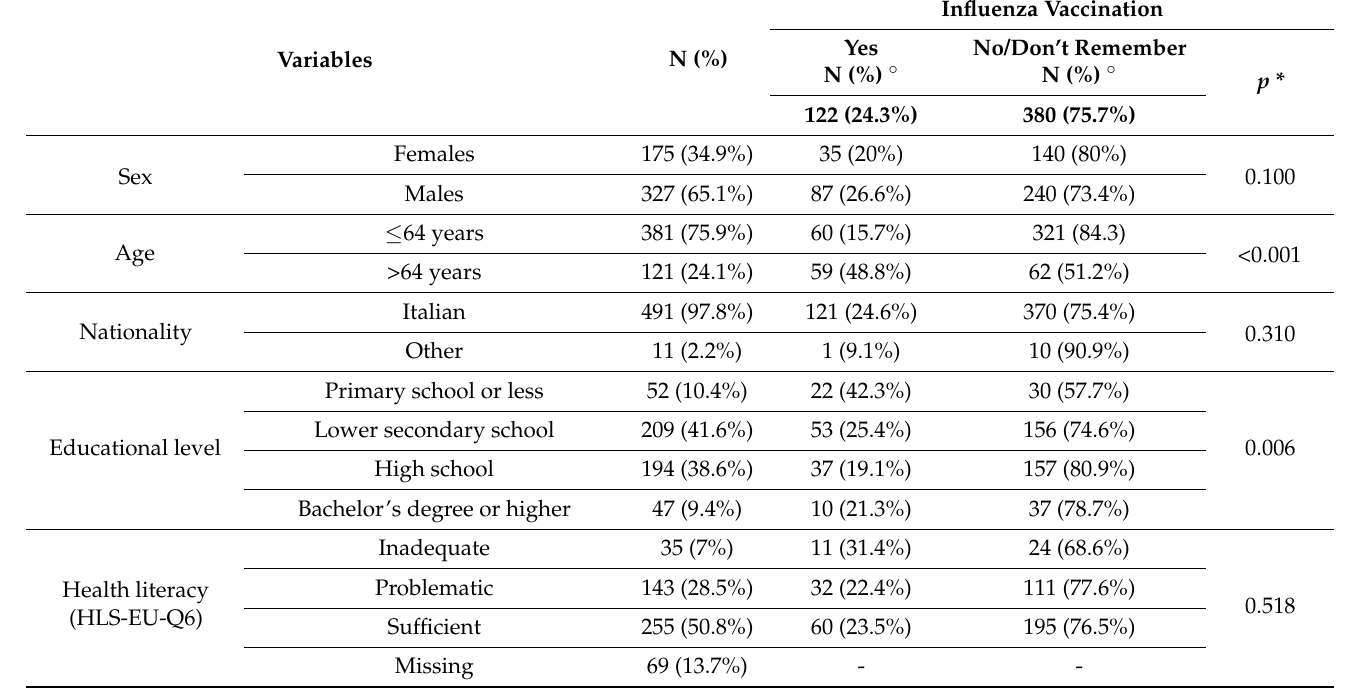
Table 1. Descriptive analysis of the categorical variables in the whole sample and by influenza vaccination uptake in the 2019–2020 season. NOTE: ◦ : row percentage; *: Fisher’s exact